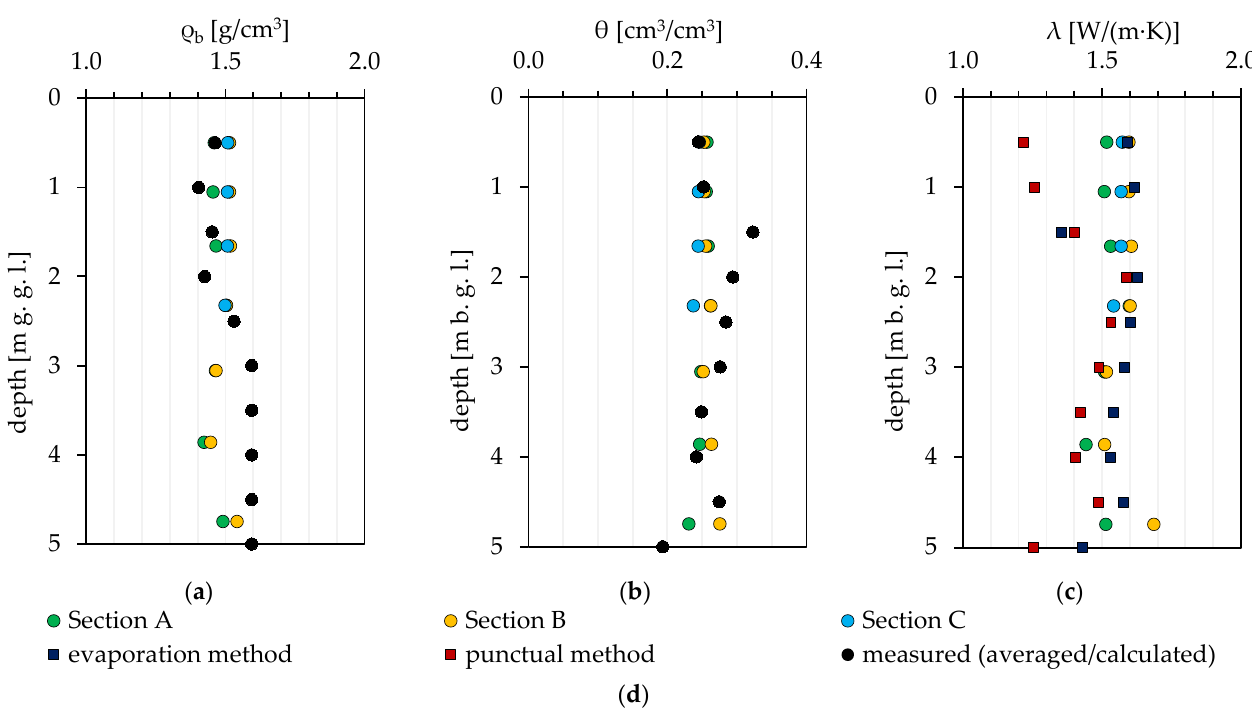
Figure 9. Comparison of average ERT-derived ( a ) bulk densities, ( b ) volumetric water contents and ( c ) thermal conductivities with measured and calculated values for the unsaturated zone. Chart legend is shown in ( d ). Table 10. Deviations between measured or calculated soil parameters and from ERTs derived and averaged values for each section. For this, the derived values from the ERT were linearly interpolated for each depth step in intervals of 0.5 m from 0.5 m b. g. l. down to a depth of a maximum 4.5 m b. g. l. Negative values mean higher values derived from